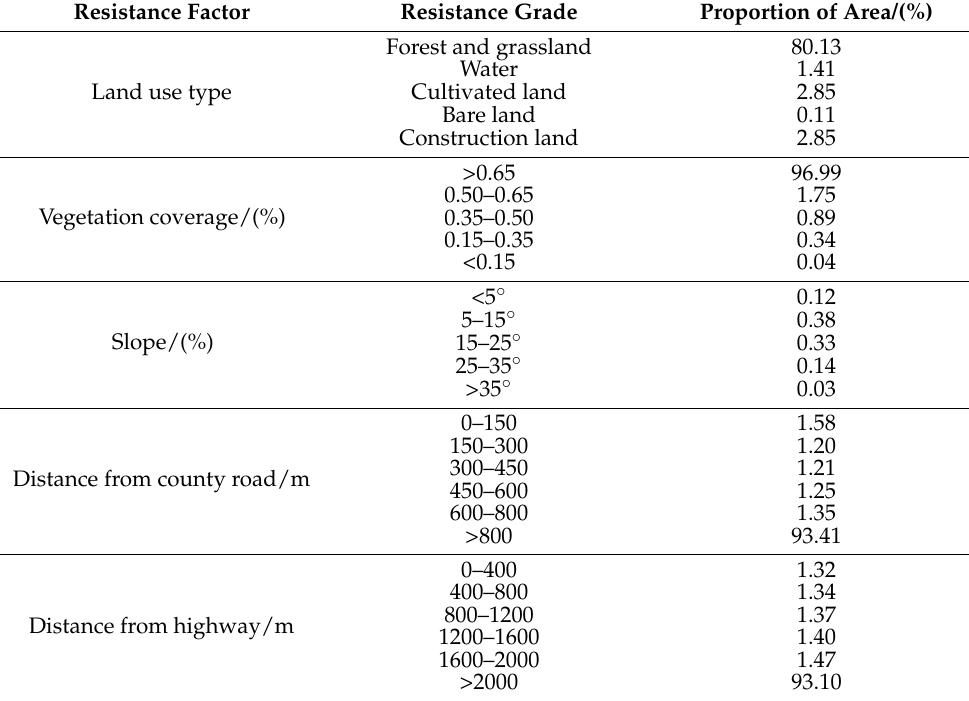
Table 6. Area statistics of ecological resistance